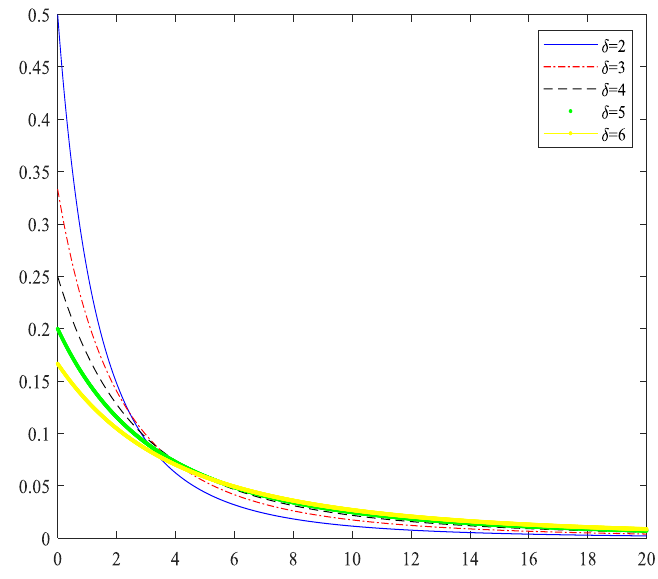
Figure 1. Comparison of δ value in GPD PDF plots.